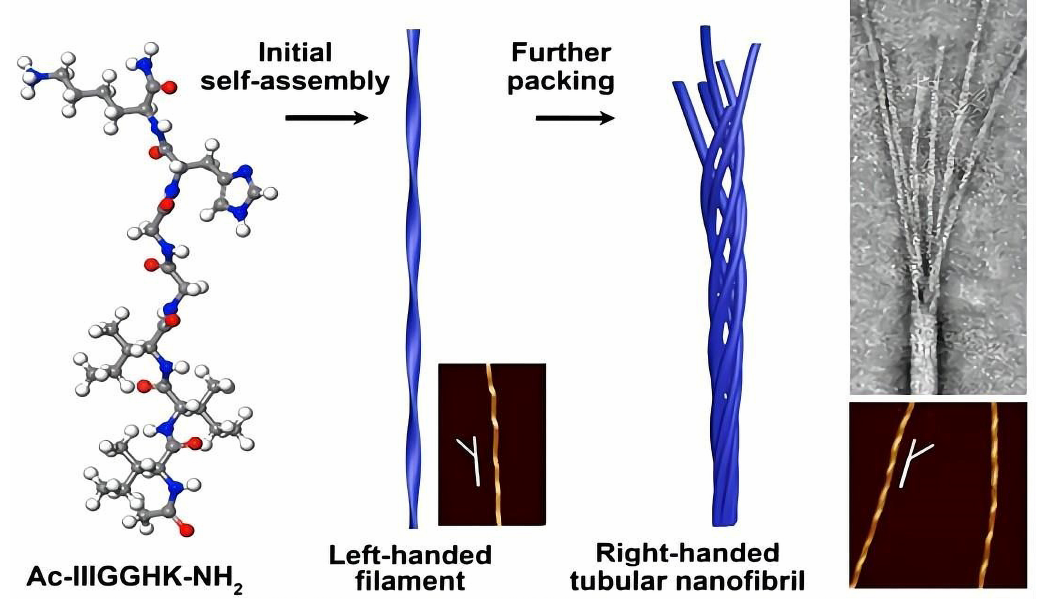
Figure 4. The self-assembly process of the amphipathic short peptide Ac-I 3 GGHK-NH 2 . Reprinted with permission from ref. [91]. Copyright (2021) American Chemical Society.